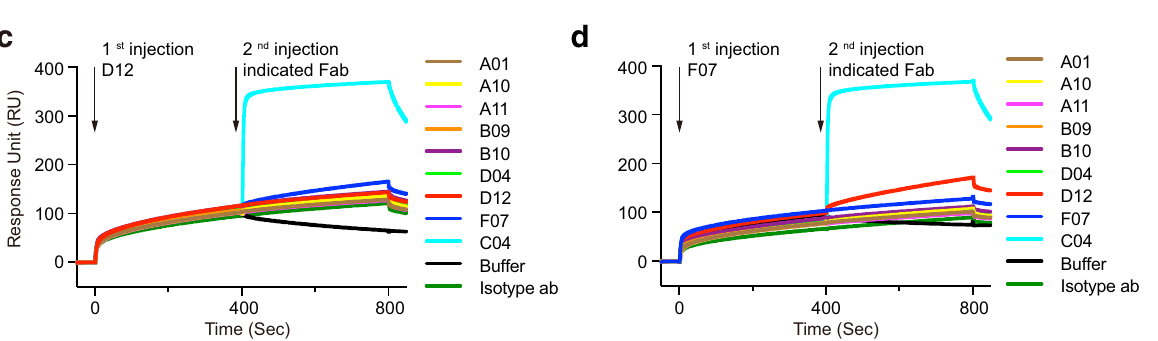
Fig. 1 Selection, classi fi cation, and neutralizing potency characterization of antibodies against the 229E S trimer. a Schematic overview illustrating the antigenic landscape mapping process of 229E S trimer. b Interaction kinetics between each Fab and 229E S trimer, S1 or S2 subunit, NTD and RBD were characterized by SPR. The results indicate that C04 is directed against 229E RBD, F12 is directed against the S2 subunit, while all the other Fabs speci fi cally interact with 229E NTD. c , d Competitive SPR results show that the eight NTD-directed Fabs all compete for a similar binding interface on 229E NTD. 229E S1 was immobilized onto the sensor, then blocked with saturating Fab D12 ( c ) or F07 ( d ), followed by a second injection of buffer only or the indicated Fabs. Fab C04 served as positive controls. e Neutralization pro fi les of IgG D12 (red), F12 (purple), F07 (orange) and C04 (black) against 229E PsV. Neutralizing activities are represented as individual data points and mean ± SD ( n = 3 biologically independent experiments). Mean ± SD is indicated with . Individual data points are shown as fi lled red squares (D12), purple triangles (F12), orange circles (F07) and black triangles (C04),